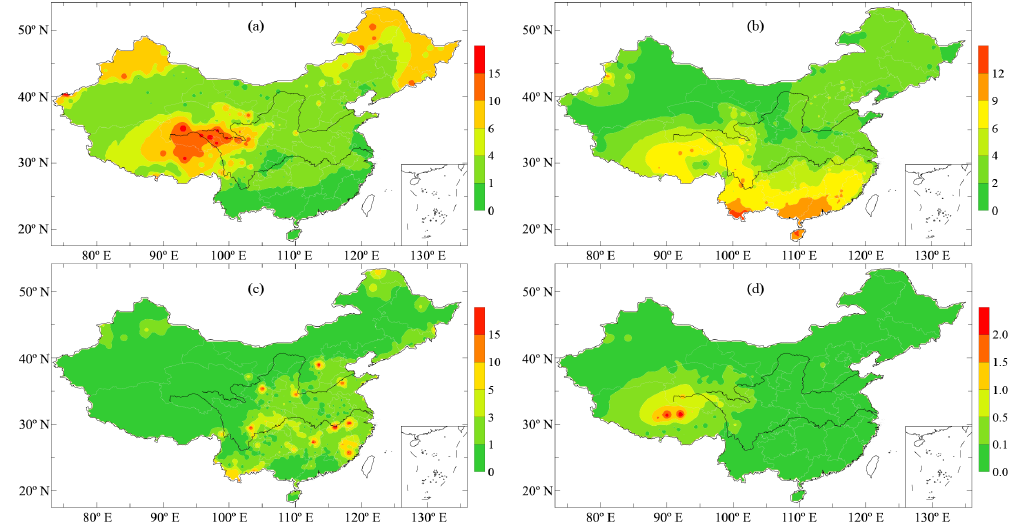
Figure 8. Spatial distribution of annual number of high-impact weather spells with more than 3 consecutive days in China during 1959–2014 (unit: timesyr − 1 ; (a) snowfall spells, (b) thunderstorm spells, (c) foggy weather spells, (d) hailstorm